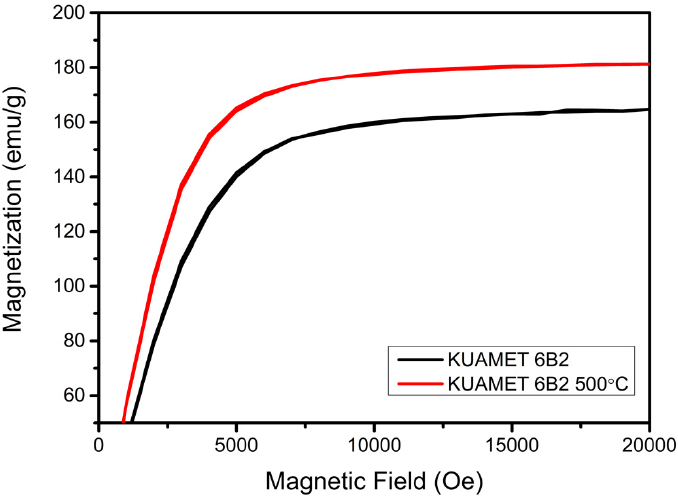
Figure 3. XRD patterns of the amorphous FeSiCrB alloy powders before (KUAMET) and after heat treatment (KUAMET 500).